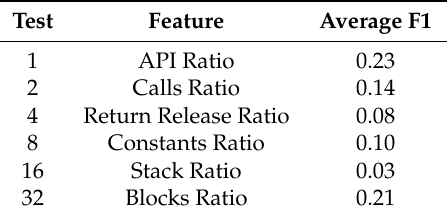
Table 9. Zeus Individual Feature Performance.